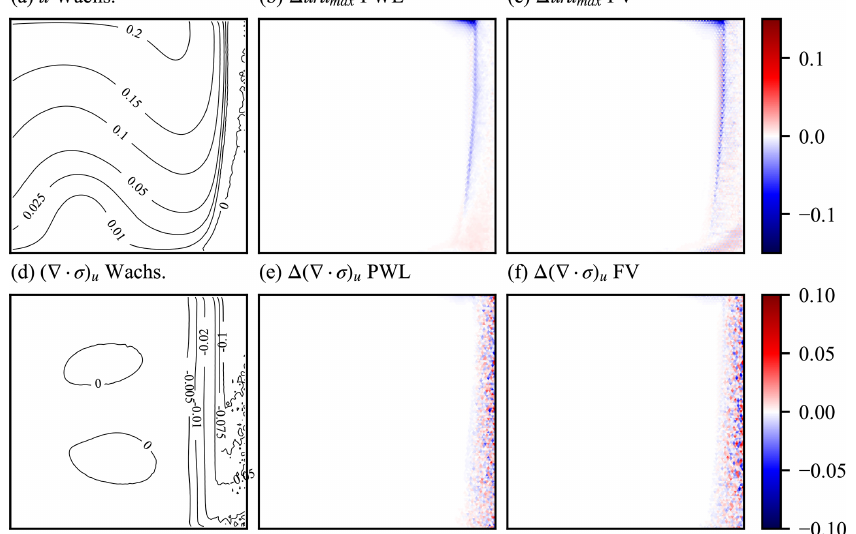
forcing, MPAS-Seaice and CICE have different orders of op- eration for interpolation in time, space, and rotation from ge- ographical to model coordinate directions, generating small differences in forcing